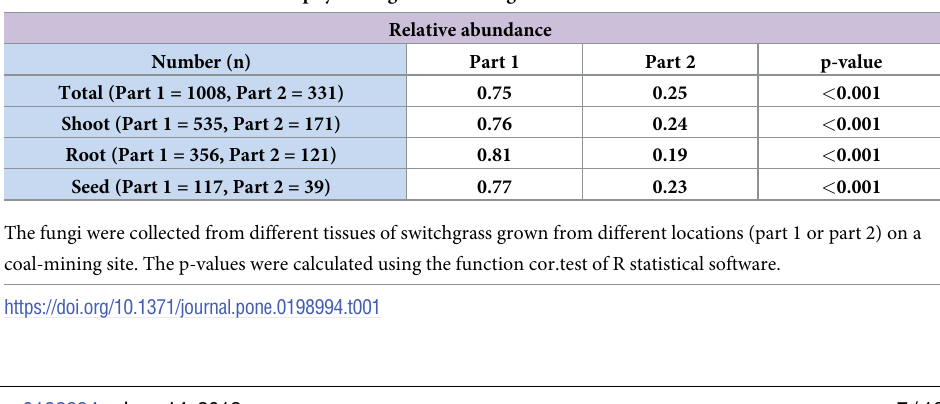
Table 1. The abundance of the endophytic fungi from switchgrass.